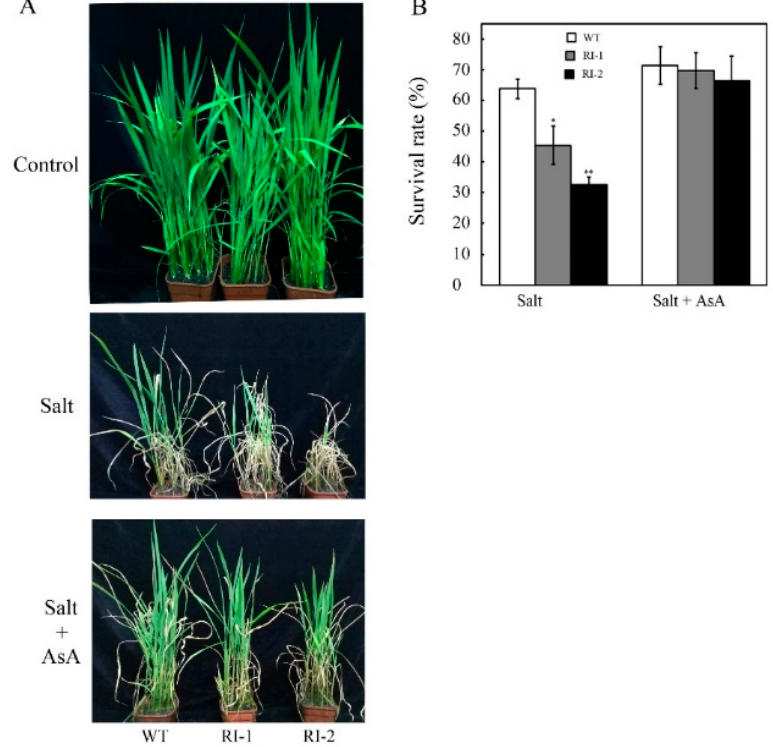
Figure 4. Exogenous ascorbic acid (AsA) rescues the tolerance of OsVTC1-3 RI plants to salt stress. ( A ) Phenotype of OsVTC1-3 RI plants grown in soil with or without supplying exogenous AsA under salt treatment. ( B ) The survival rate of OsVTC1-1 RI plants with or without supplying exogenous AsA under salt treatment. Control indicates that rice seedlings were grown under normal conditions; NaCl indicates that rice seedlings were grown in soil by watering with 150 mM NaCl; AsA indicates that rice seedlings were grown in soil by supplied with 10 µ M AsA; and NaCl + AsA represents rice seedlings grown in soil with 150 mM NaCl and 10 µ M AsA. The above assays were repeated three times. About 50–60 seedlings were used in each experiment. The bars represent SE ( ± ). The asterisk indicates results significantly different from WT (** p < 0.01 and * p < 0.05). Significance was evaluated by the t -test.